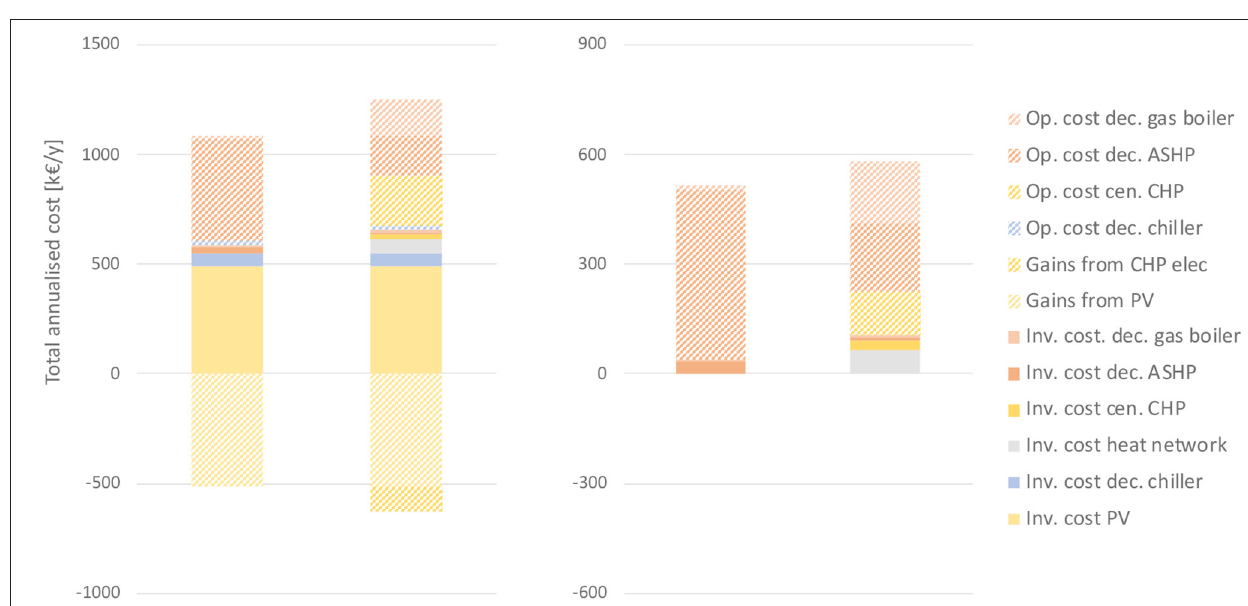
FIGURE 13 | Cost structure of the pathways (left: total costs; right: heating